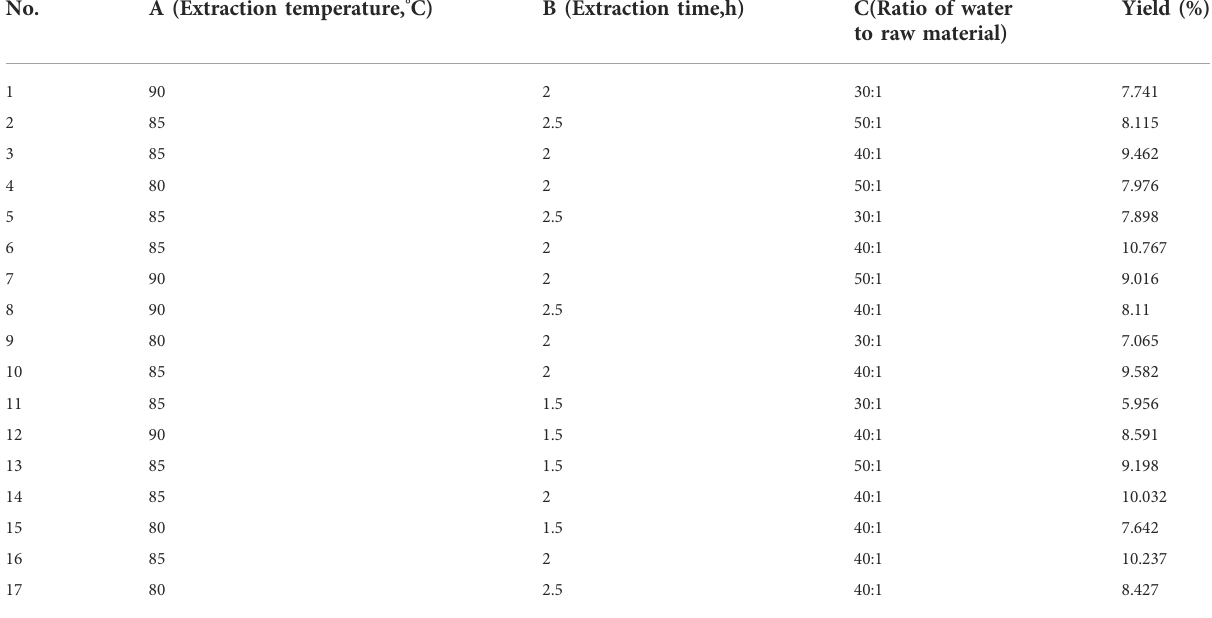
TABLE 2 Box – Behnken design (coded) and results for extraction yield of RFP. No.